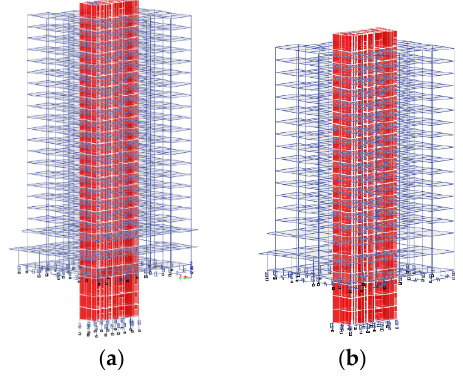
Figure 1. Three ‐ dimensional view of prototype buildings: ( a ) C1 and ( b ) C4. Figure 1. Three-dimensional view of prototype buildings: ( a ) C1 and ( b )